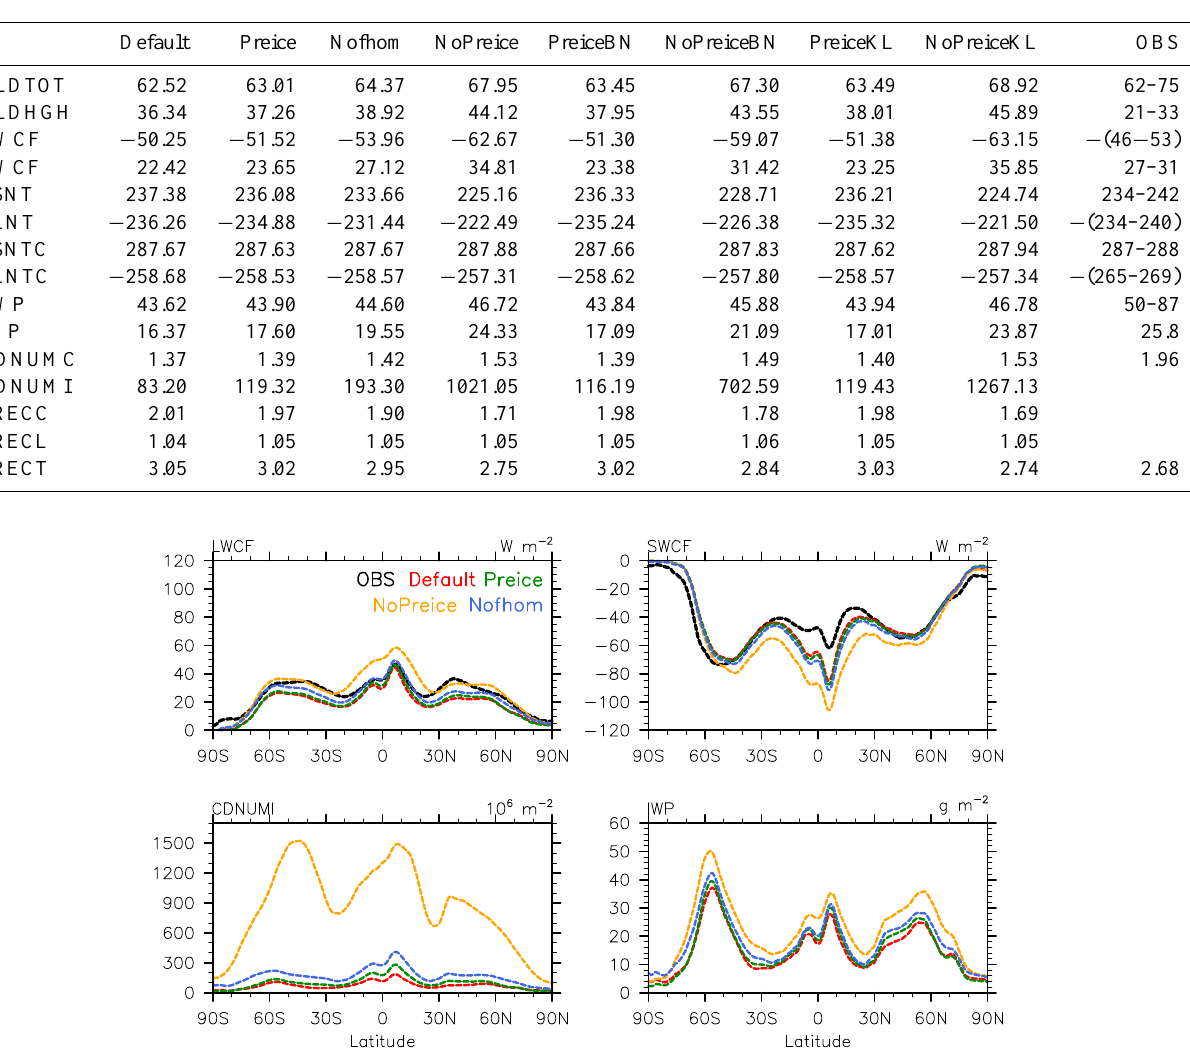
Table 2. Global annual mean results from present-day simulations and observations. Shown are total cloud fraction (CLDTOT,%) and high cloud fraction (CLDHGH, %) compared to ISCCP data (Rossow and Schiffer, 1999), MODIS data (Platnick et al., 2003) and HIRS data (Wylie et al., 2005); shortwave cloud forcing (SWCF, Wm − 2 ) , long-wave cloud forcing (LWCF, Wm − 2 ) , whole-sky shortwave (FSNT, Wm − 2 ) and long-wave (FLNT, Wm − 2 ) net radiative fluxes at the top of the atmosphere, clear-sky shortwave (FSNTC, Wm − 2 ) and long- wave (FLNTC, Wm − 2 ) radiative fluxes at the top of the atmosphere compared to ERBE data (Kiehl and Trenberth, 1997) and CERES data (Loeb et al. 2009); liquid water path (LWP; gm − 2 ) compared to SSM/I oceans data (Greenwald et al., 1993; Weng and Grody, 1994) and ISCCP data (Han et al., 1994); ice water path (IWP, gm − 2 ) compared to CloudSat data (Li et al., 2012); column-integrated grid-mean cloud droplet number concentration (CDNUMC, 10 10 m − 2 ) compared to MODIS data (Table 4 in Barahona et al., 2014); column-integrated